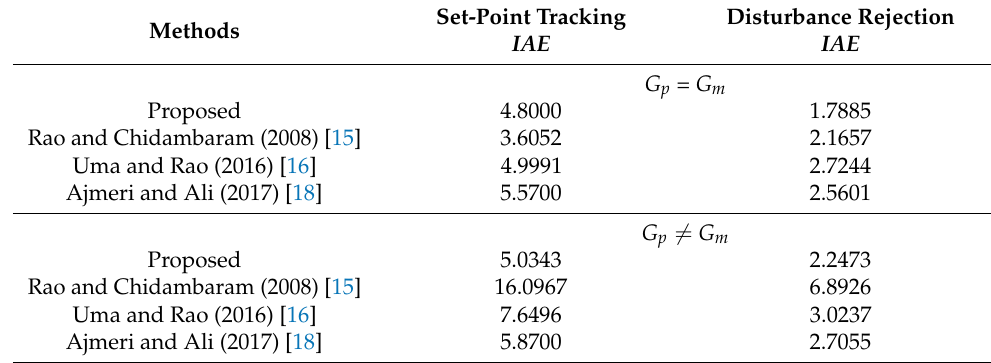
( b ) Figure 12. Performance comparison of the proposed method, in terms of noise effects, for Example 2. ( a ) Test result for noise Signal 1 and ( b ) test result for noise Signal 2 [18].